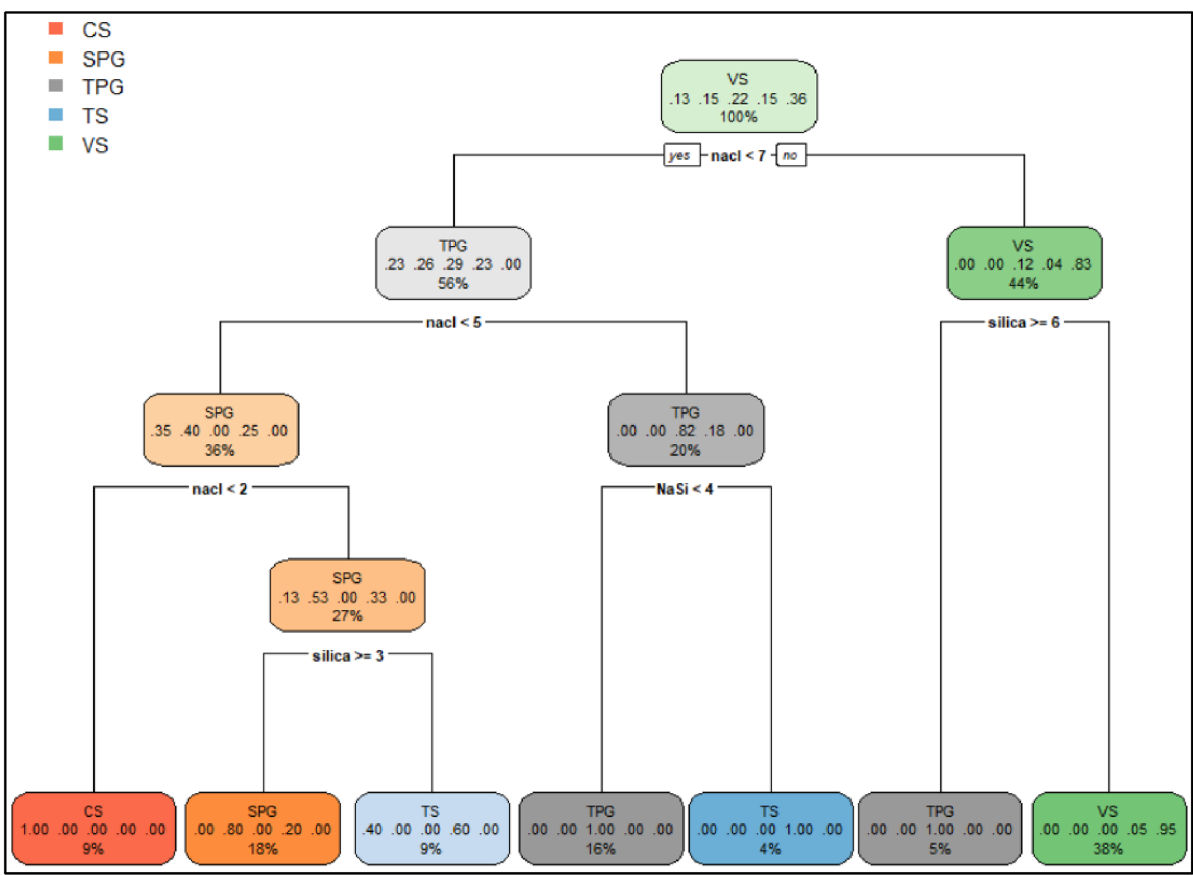
Figure 4. Tuned decision tree diagram developed by machine learning in R by CARET package 29 using bottle test results. 10-k repeated cross validation with three repeats was performed using 20% of data (p = 0.8). Each node represents the predicted class (top), the predicted probability of each class (middle), the percentage of observations in the node (bottom). CS clear suspension, SPG single-phase gel, TPG Two-phase gel, TS turbid suspension, VS viscous liquid. Concentrations included on the nodes are in weight